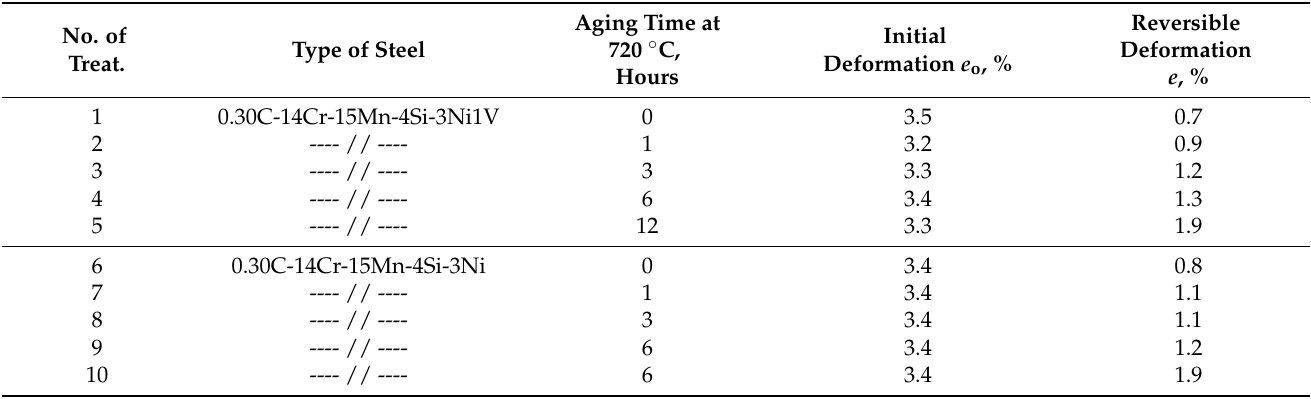
Table 3. Reversible deformation e in the stainless SME steels quenched from 1100 ◦ C dependent on the aging time at 720 ◦